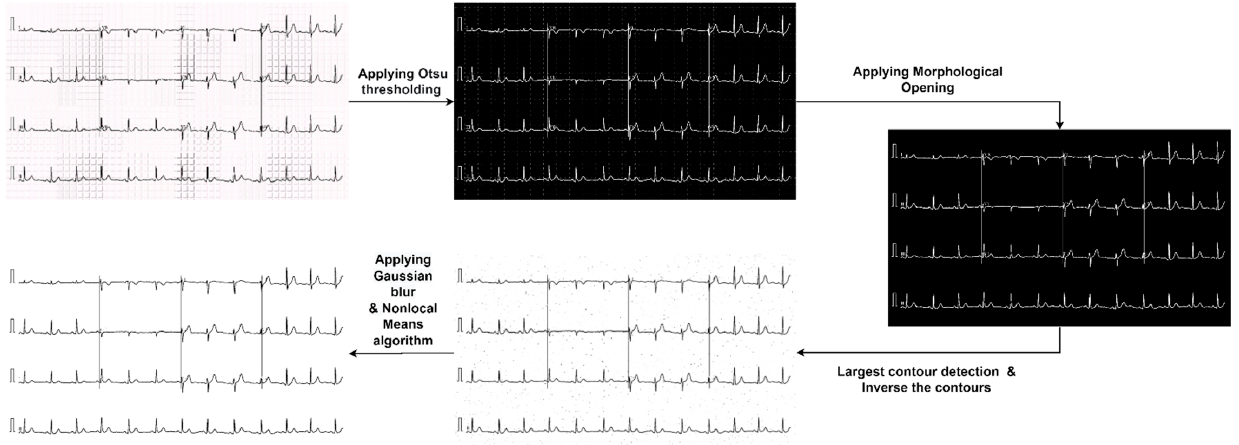
Figure 6. Graph line removal method.